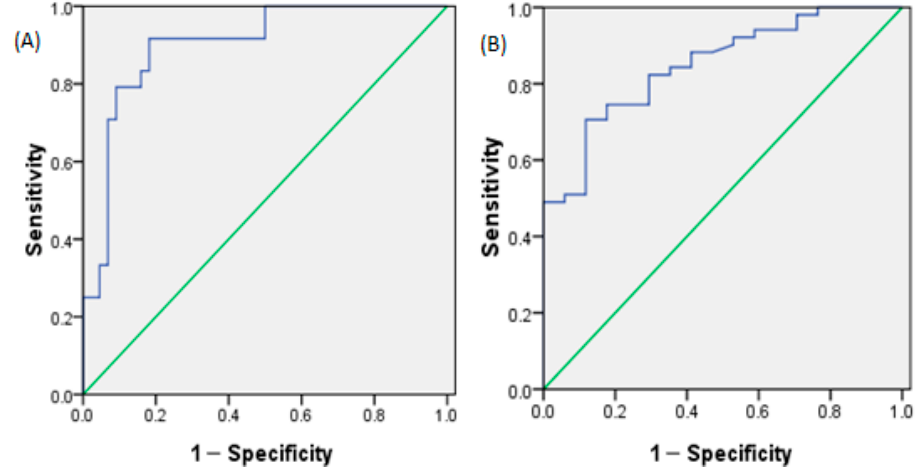
Figure 3. Receiver operating characteristic curve (ROC) analysis curve of the daily total fluid intake for assessing optimal hydration and assessing hypohydration. ( A ) ROC for assessing optimal hydration. ( B ) ROC for assessing hypohydration.